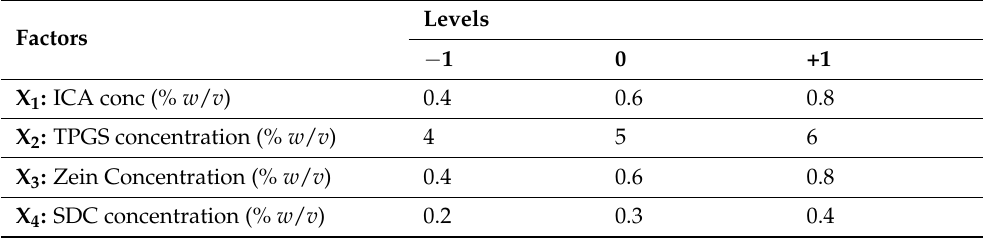
Table 1. Factors’ levels (coded and actual) and responses’ desirability constraints in the response surface D-optimal design used for optimization of ICA–tocozeinolate nanospheres.